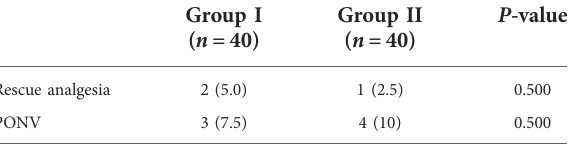
TABLE7 Comparison of rescue analgesia and PONV between the two groups.